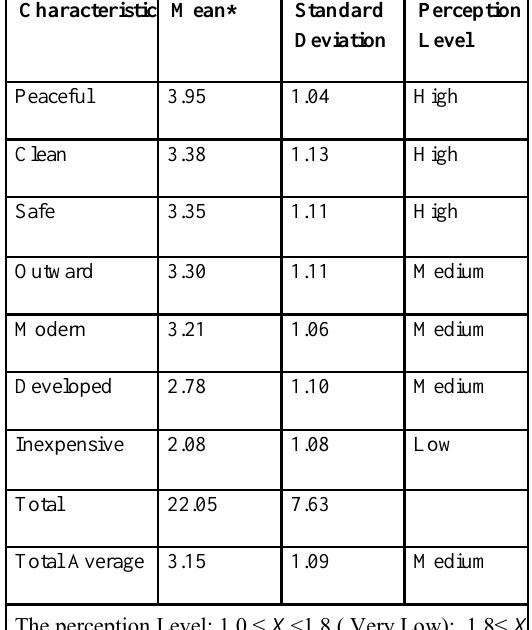
Table 5. Image Perceptions of Residents of